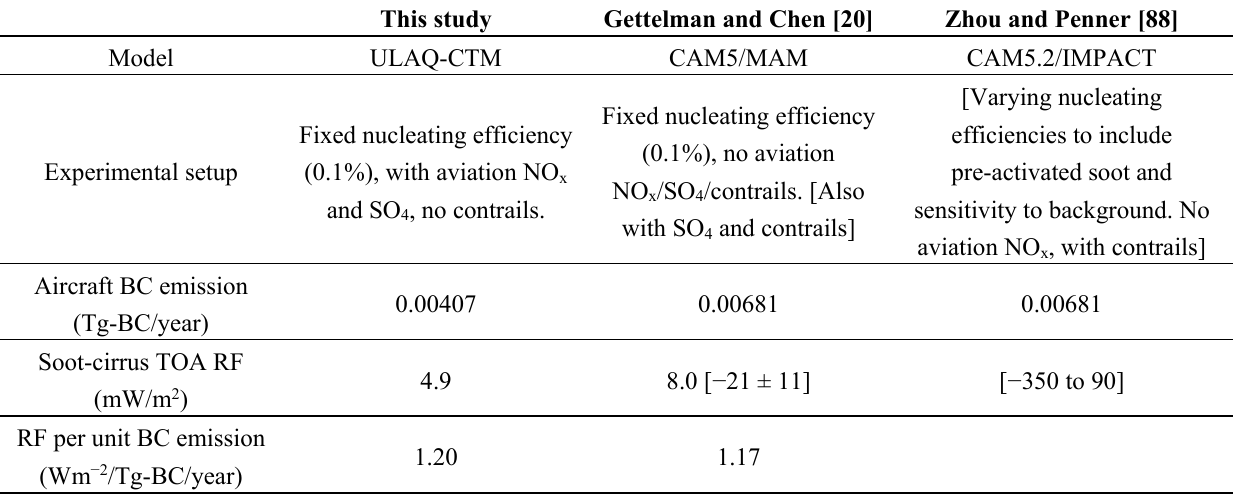
Table 7. RF from other soot-cirrus studies. Relevant experiments not directly comparable to this study are also included for illustrative purposes.